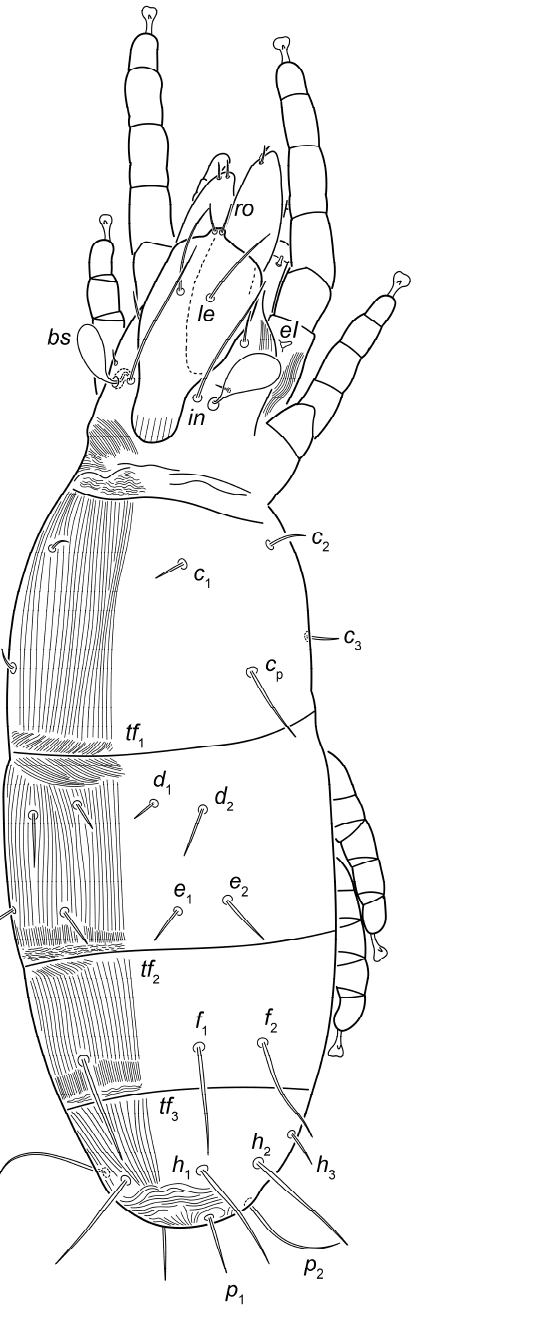
Figure 8. Paralycus daeira sp. n., protonymph: ( A )—dorsal view; ( B )—ventral view. Scale bar 100 µ m. The larvae and deutonymphs of P. daeira and P. laviopierrei are very similar. They differ by solenidion ϕ of tibiae III longer than half the length of tibia III in P. daeira (distinctly shorter in P. laviopierrei ); in addition, deutonymphs of these two species can be distinguished by the absence of leg seta v (cid:48) on trochanters III in P. daeira (present in P. laviopierrei